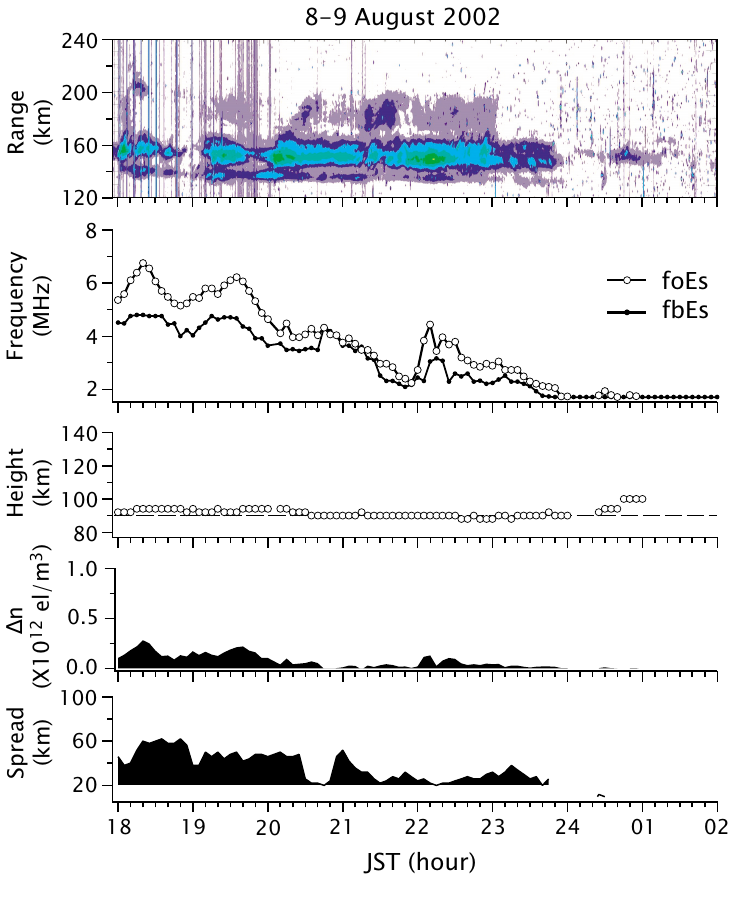
Fig. 5. Same as Fig. 3, but for the night of 8 to 9 August 2002. The radar echoes were of the continuous type.